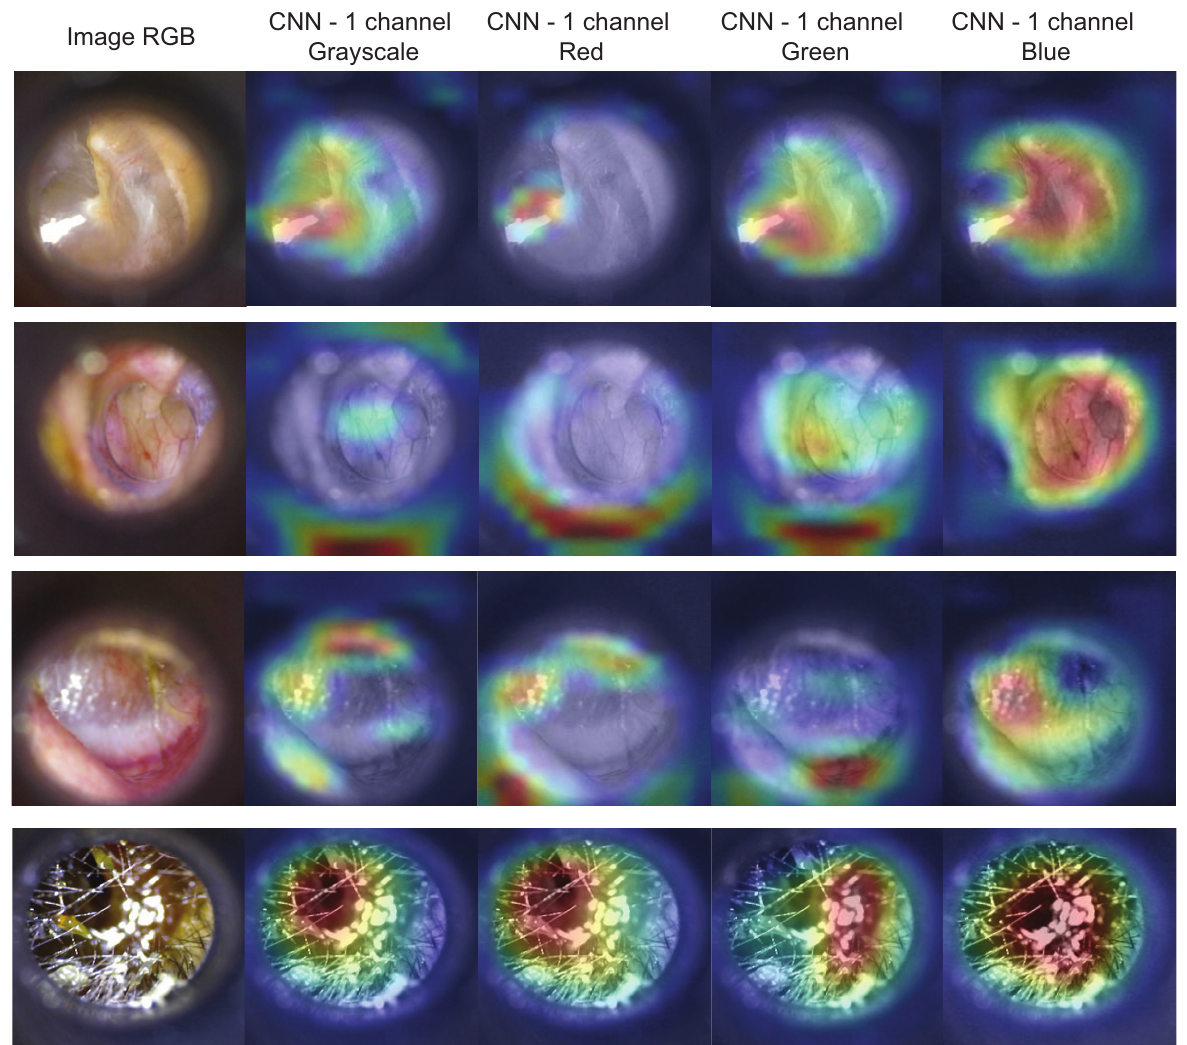
Figure 7. Visual representation of class activation heatmap obtained from the last group of convolu- tional neural networks using Grad-CAM, overlapped with an original image: (per row, from top to bottom) normal ear, chronic otitis media, otitis media with effusion, and earwax